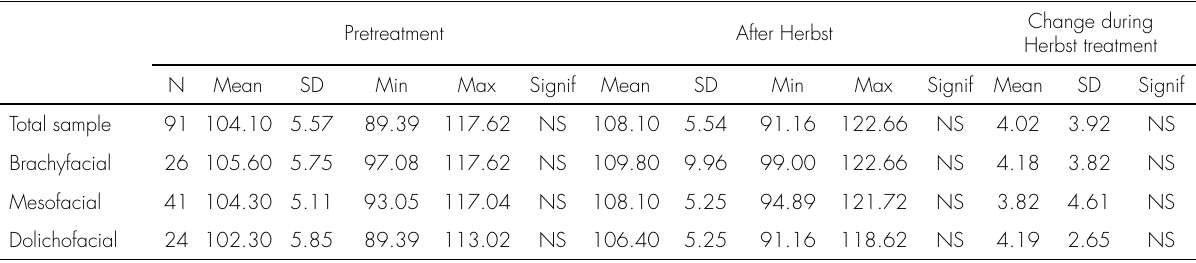
SD = Standard deviation, Min = minimum value, Max = maximum value, Signif = ANOVA, significant differences in means, NS = Not significant. * = p ≤ 0.05 ** = p ≤ 0.05, significant difference in vertical pattern subgroup Table IX. Pog ’ to Pog (mm).